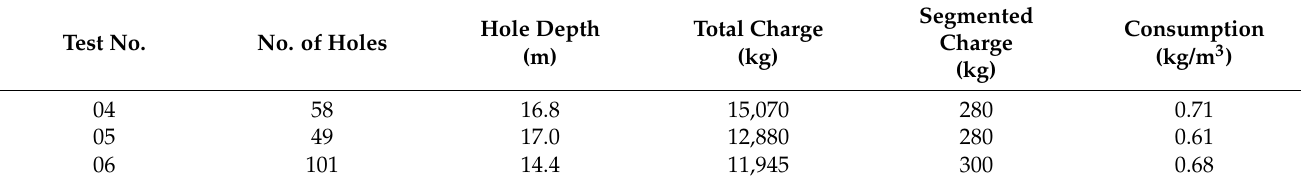
Table 4. Explosive blasting test